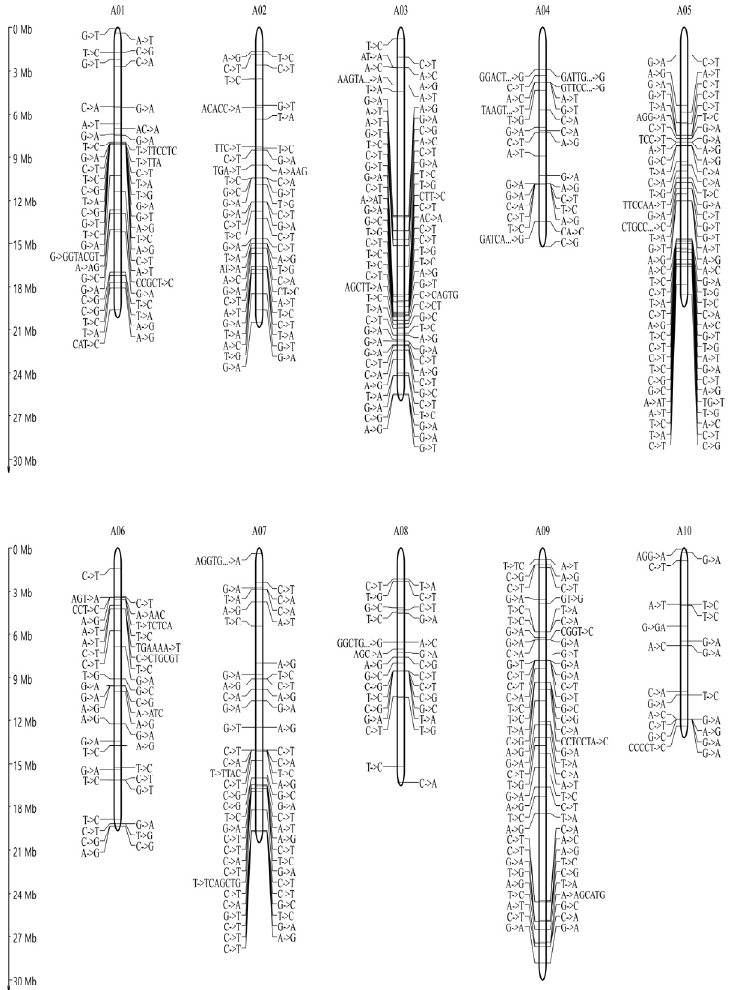
Figure 4. Chromosomal location of detected SNP and InDel in the transgenic Chinese cabbage plants. A total of 3294 SNP and InDel candidates occurring in both T 1 and T 3 transgenic plants were identified. The SNP and InDel candidates were distributed throughout the entire chromosome.